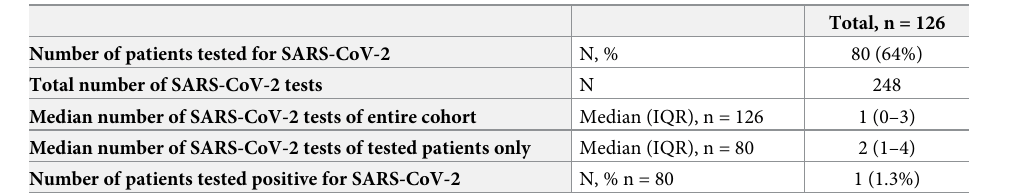
Table 3. SARS-CoV-2 testing.